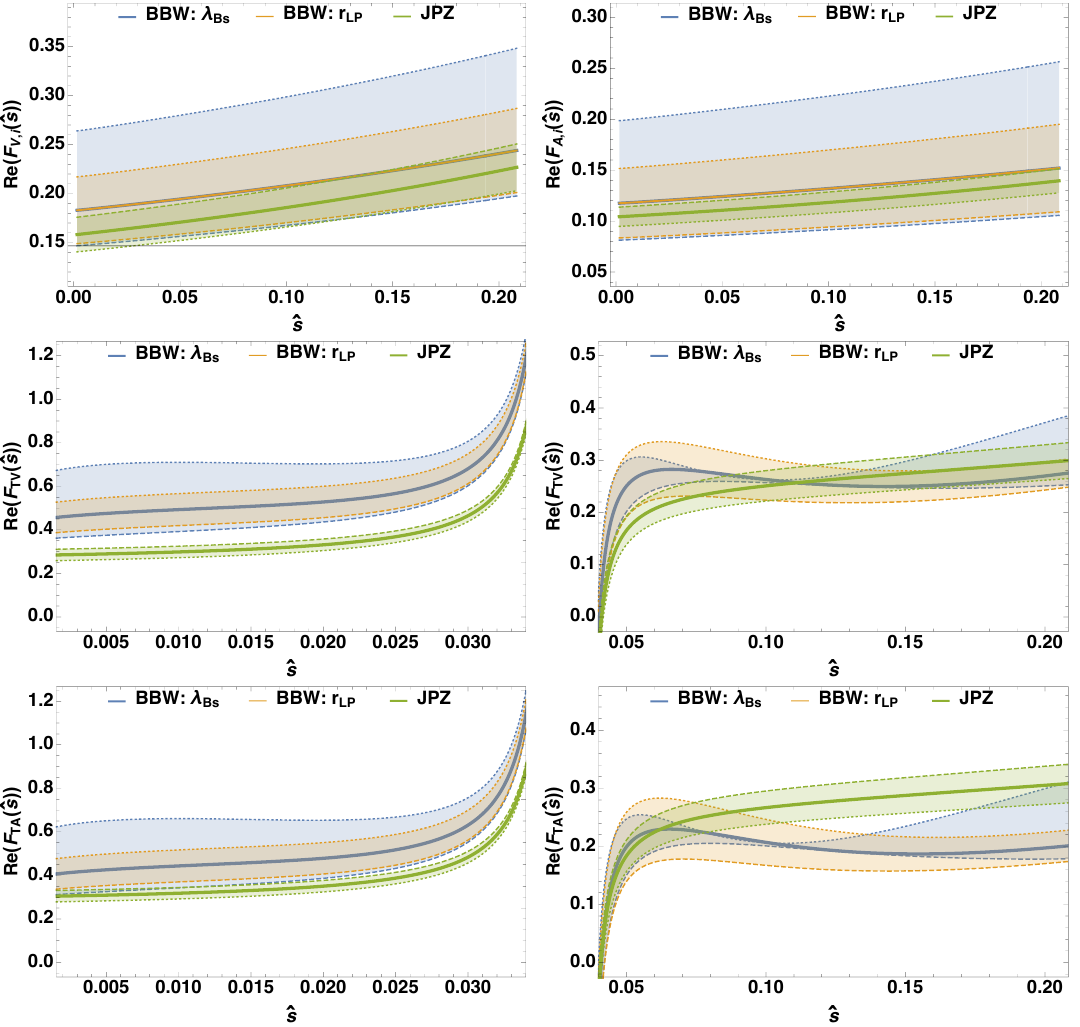
¯ Figure 6 . Comparison of the real parts of JPZ f.f.’s F V , F A (first row left vs. right), F TV (second row), ¯ F (third row), with the BBW ‘effective’ f.f. counterparts in eqs. (B.2)–(B.3). Note that TA the first row shows vector and axial f.f.’s with an index i = 9 , 10 , as in eqs. (B.2). The BBW-f.f. range of variation due to the λ and to the r uncertainties, both discussed in the text, are B s LP shown separately (see legend entries). For rendering reasons, in the instance of tensor f.f.’s we show separately the cases of ˆ s below (left panels) and respectively above (right panels) the φ